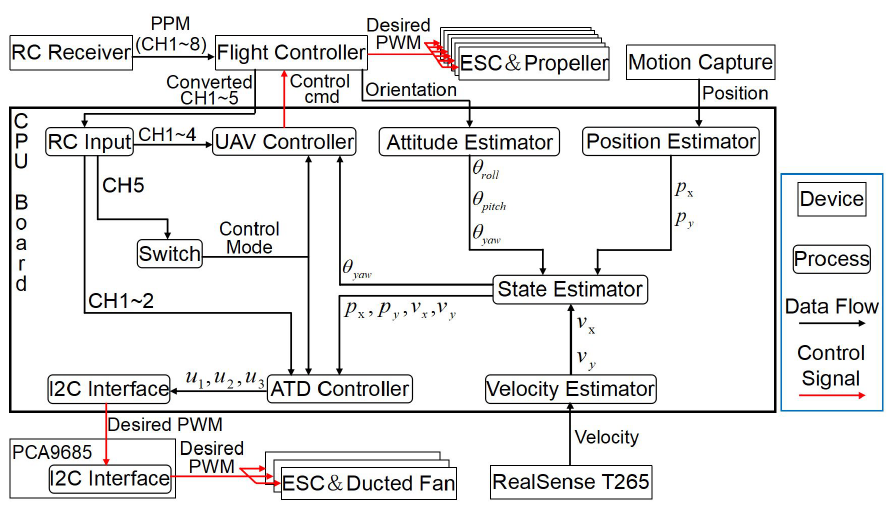
Figure 4. Block diagram of the ATD with multirotor